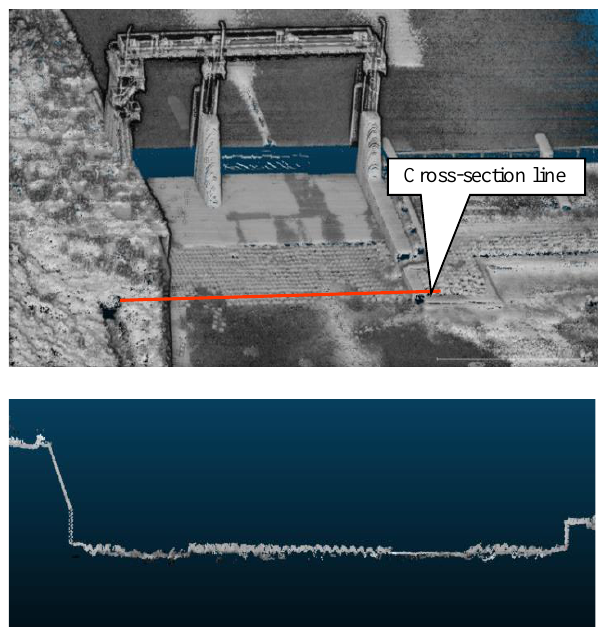
Figure5. Bird's-eye view and Cross-section Around River Weir